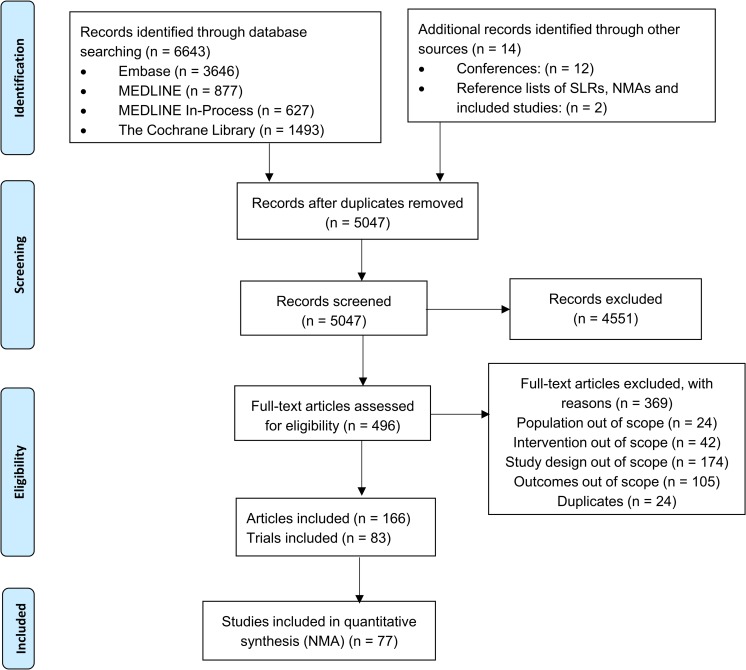
PRISMA flow diagram.